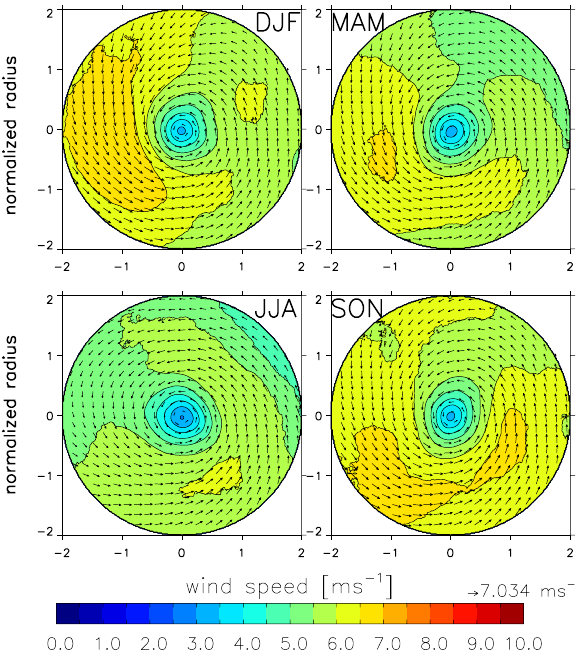
Fig. 9. Mean seasonal wind at the position of detection, normalized by radius. Shown are mean vector components and, as color, the mean value of wind speed. Isoline interval is 0.5ms − 1